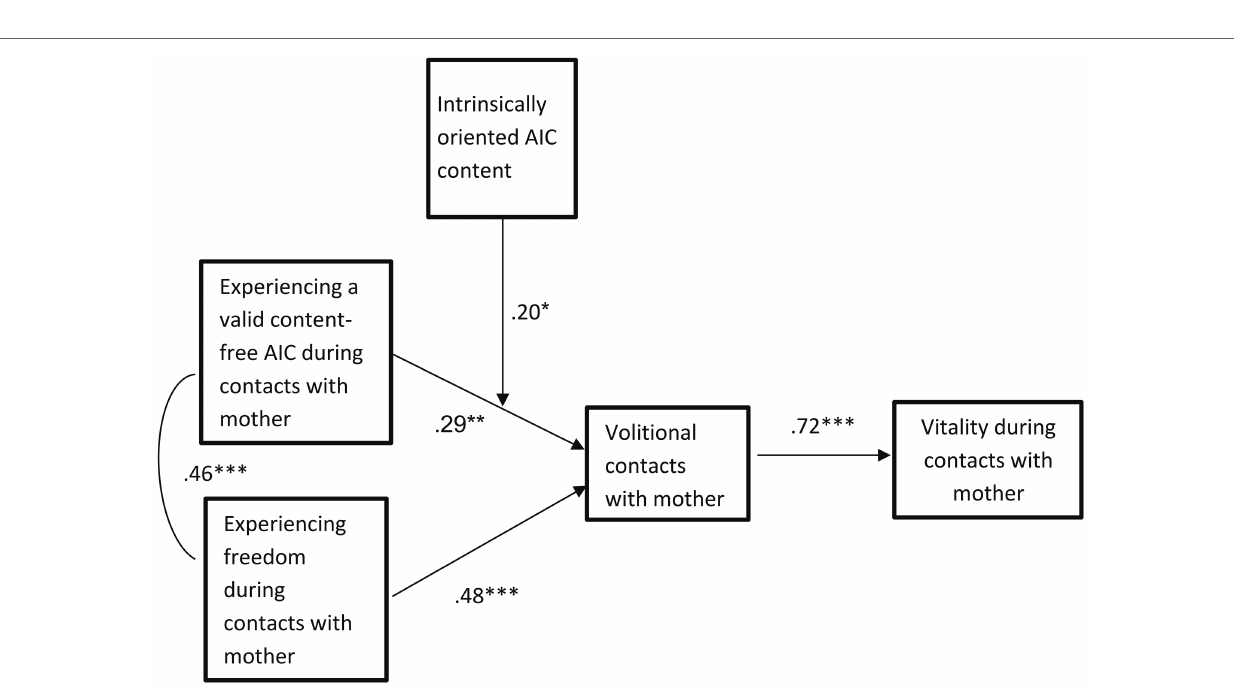
FIGURE 2 | Intrinsically oriented AIC content as a moderator of the effect of experiencing content-free AIC during contacts with mother on volitional contacts and subsequent vitality in the Israeli sample. * p < 0.05; ** p < 0.01; *** p <